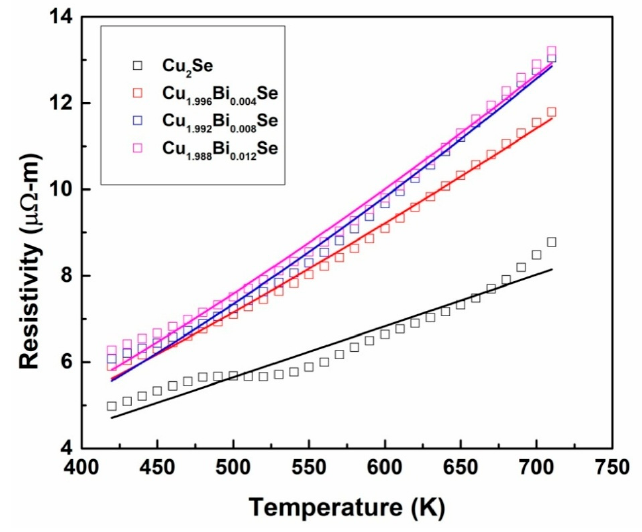
Figure 9. Resistivity data fitted with Power law (Equation (9)).